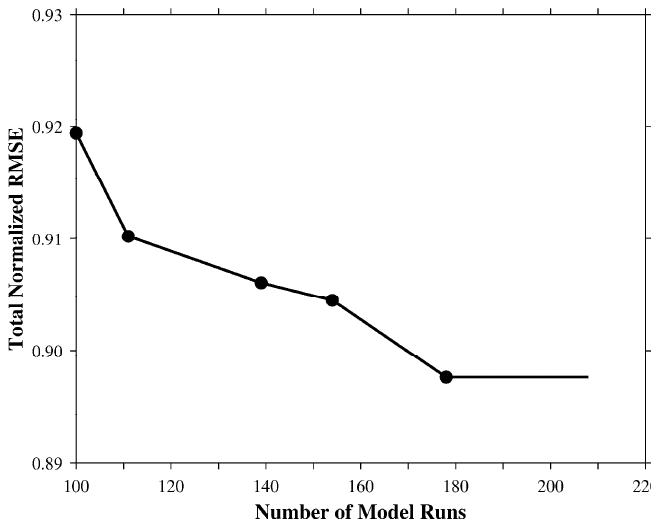
Figure 4. Optimization speed for total normalized RMSE of the precipitation and 10-m wind simulations using the ASMO method.